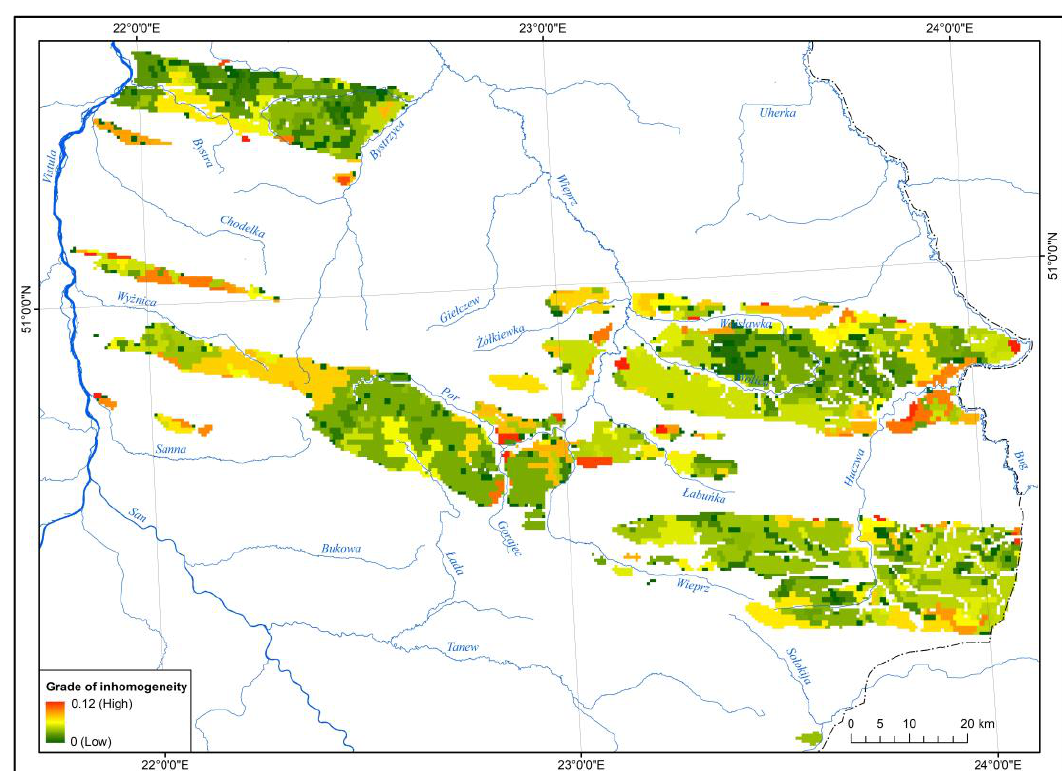
Figure 8. Grade of inhomogeneity of unique segments of loess patches.